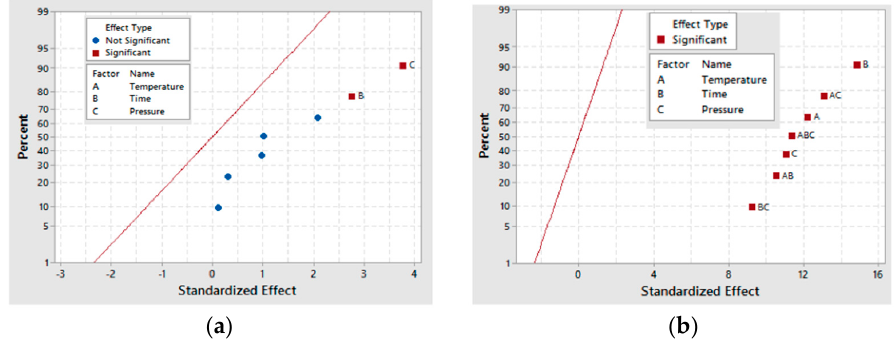
Figure 6. Half normal plots for tartronic acid production for ( a ) the 30-min and ( b ) the 60-min as-deposited electroless CuNiMoP/Al 2 O 3 oxidation reactions.